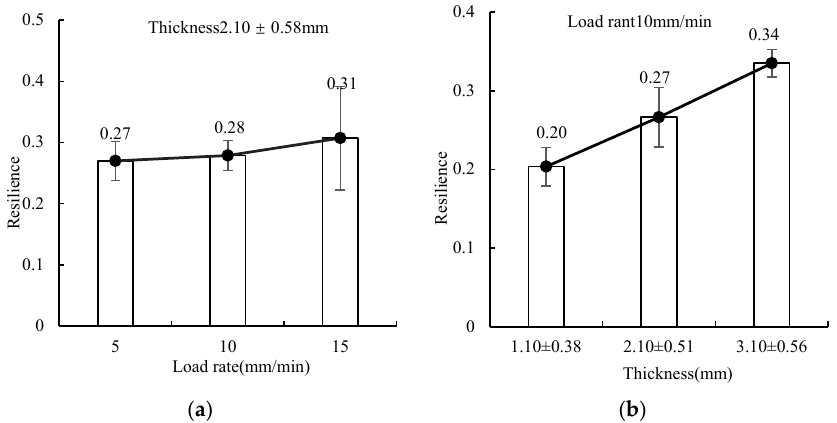
Figure 17. Resilience of wakame stem under different thickness and loading rate. ( a ) Resilience of wakame stem under different load rate; ( b ) Resilience of wakame stem under different thickness.